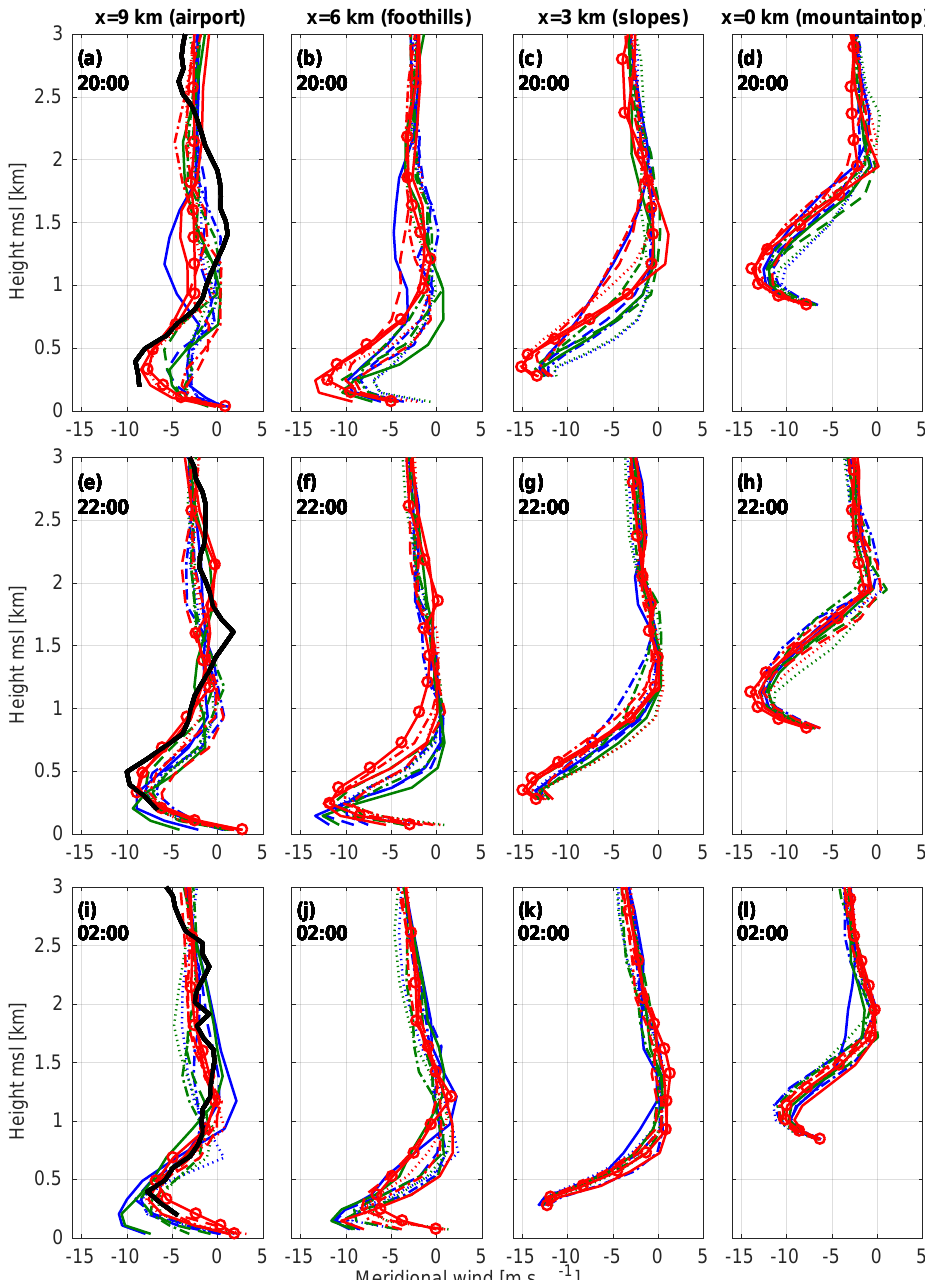
Figure 8. Time evolution of vertical profiles of the meridional wind during the 11–12 March Sundowner case study from observations (black line, only at the wind profiler location) and model sensitivity experiments (see Figure 6 for legend) for the ( a , e , i ) wind profiler, ( b , f , j ) foothill, ( c , g , k ) slope, and ( d , h , l ) mountaintop locations, see also Figure 7e for the exact locations of each profile. Times (in PST) are indicated in all